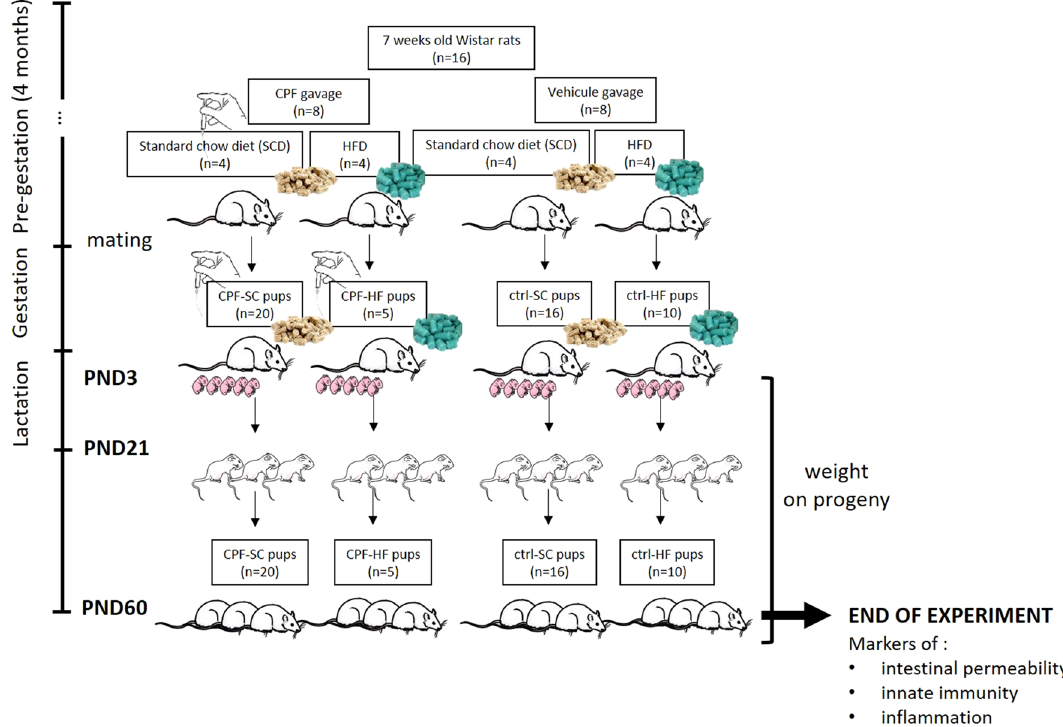
Figure 10. Experimental procedure. Created with BioRender.com ; on the left-hand side of the figure is indicated the chronology of the experiments and on the main panel the events to which dams and progeny were submitted. ctrl control, CPF chlorpyrifos, HFD high fat diet, SCD standard chow diet, PND postnatal phosphorothioate solution (1 mg/kg/day po—1 mL/kg/day) (LGC Standards Laboratory, Molsheim, France) or its vehicle rapeseed oil (1 mL/kg/day) (MP Biomedicals, Illkirch, France) (Fig. 10). Each group was further